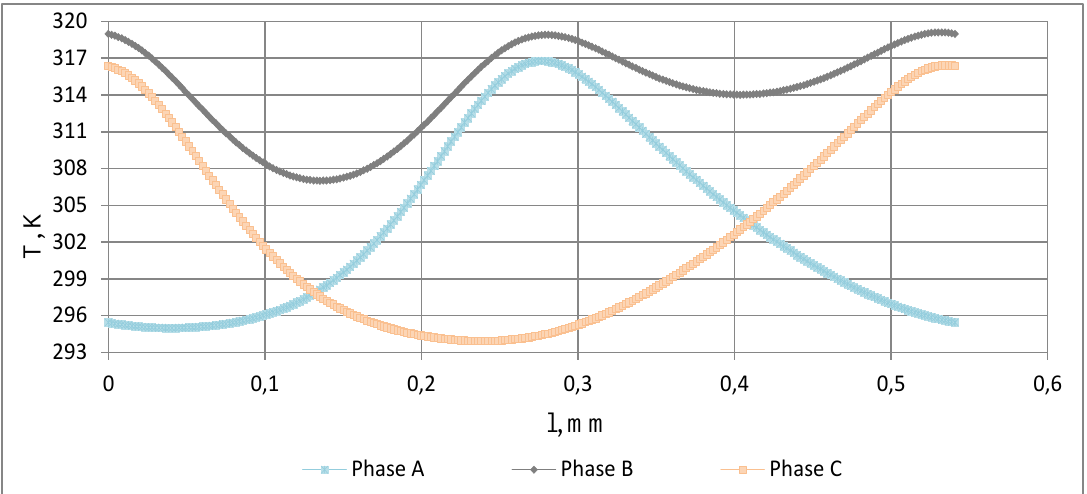
Figure 6. Temperature distribution on the cable surface for the maximum negative temperature difference in a flat